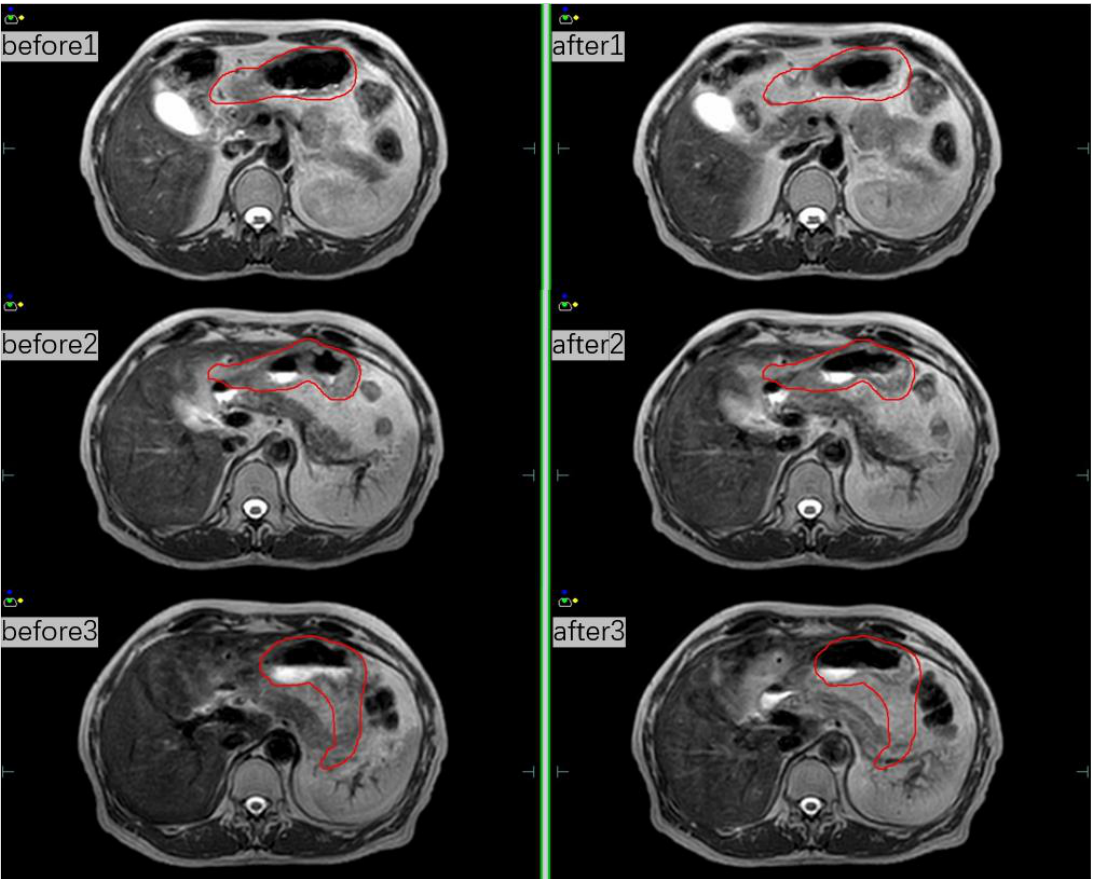
Figure 3. MRI scans before and after treatment at three different fractions and the red line indicates the whole stomach.